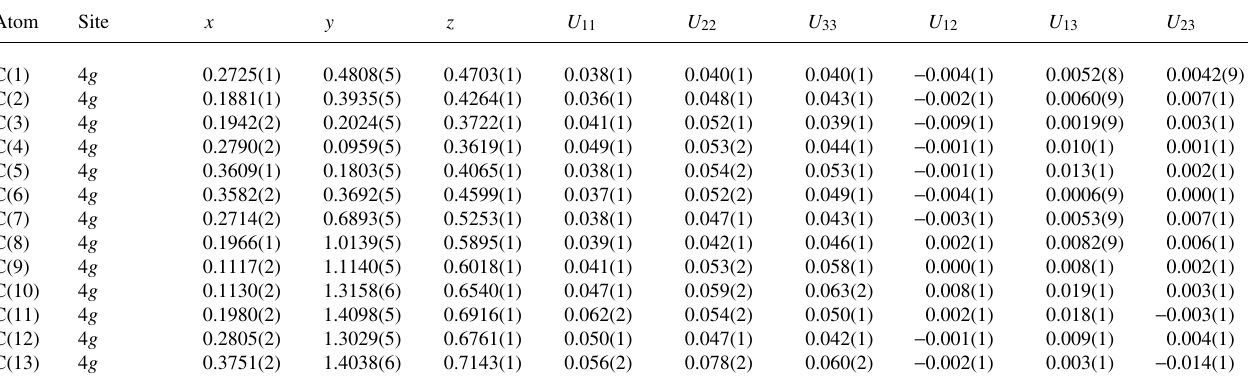
6. Zhang, X.-L.: Crystal structure of trans -bis[4-chloro-2-(iminomethyl)- phenolato]nickel(II), Ni(C 7 H 5 ClNO) 2 . Z. Kristallogr. NCS 224 (2009) 679-680. 7. Wang, Y.-Z.; Li, L.-L.; Su, Y.-Q.; Li, C.: Crystal structure of dichloro( N - ethyl- N'